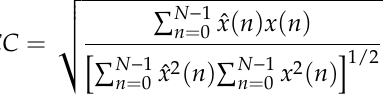
10 mm and 1 mm; ( f ) The size of 45-degree crack is1 mm × 20 mm × 1 mm. and 1 mm; ( f ) The size of 45-degree crack is 1 mm × 20 mm × 1